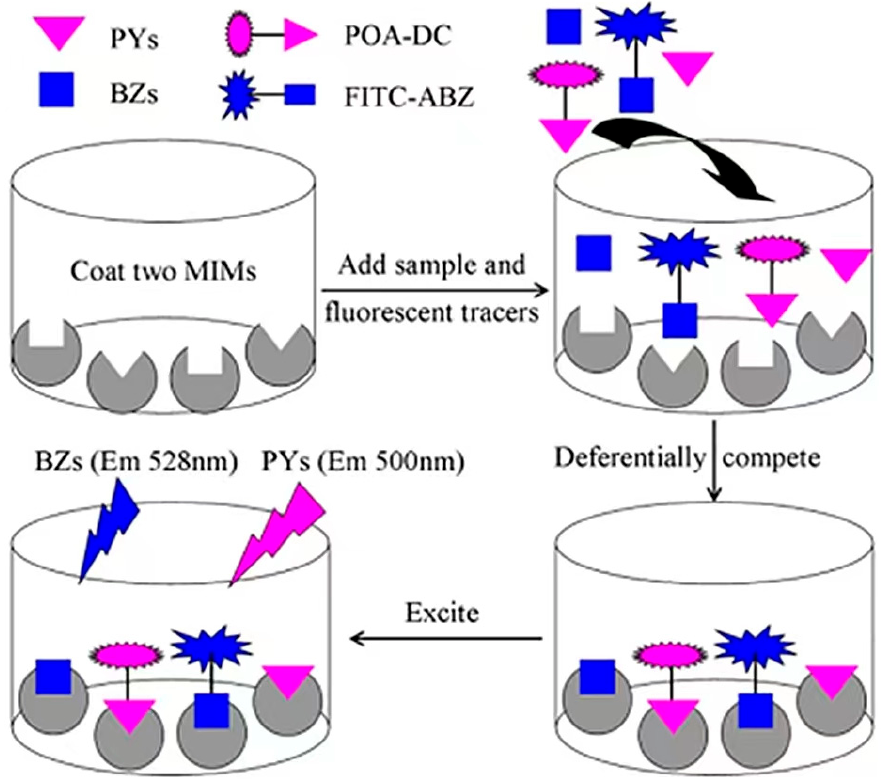
Figure 3. Assay principles of the MIM-based multiplexed fluorescence method ([60]).